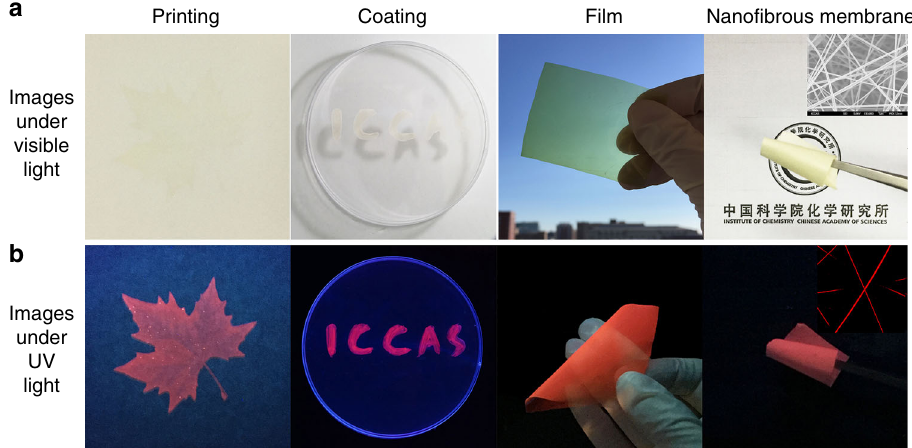
Fig. 2 Processability of cellulose-based ratiometric fl uorescent materials. Images of a cellulose-based dual-emission fl uorescent material with a red initial fl uorescence in different material forms under a visible light and b 365 nm UV light. The insets are SEM and CLSM images of nano fi brous membrane, respectively